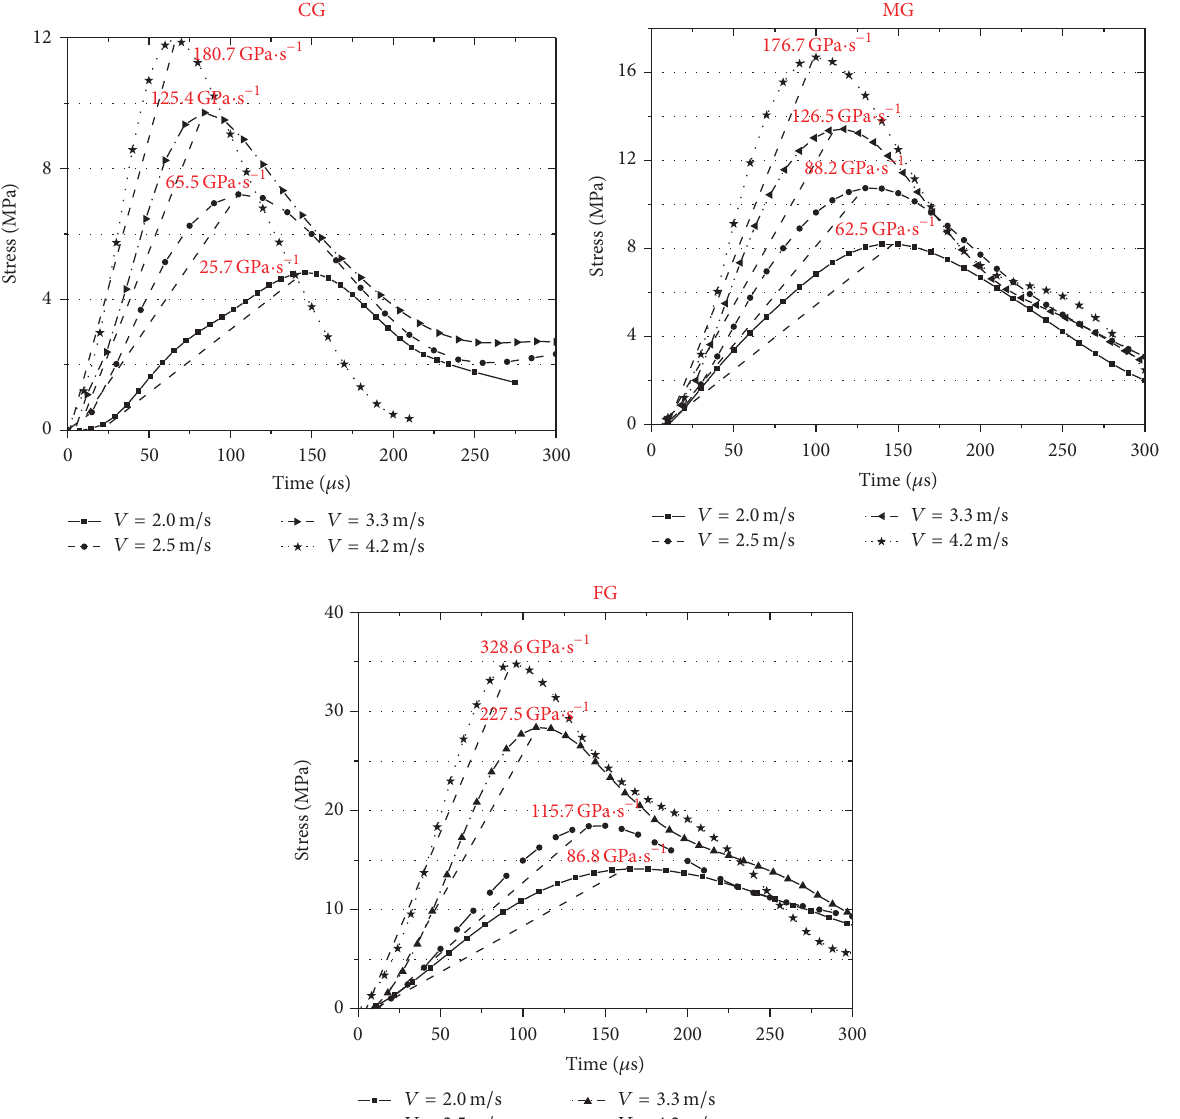
Figure 11: The time history of tensile stress at the center of Brazilian disc sample of three kinds of